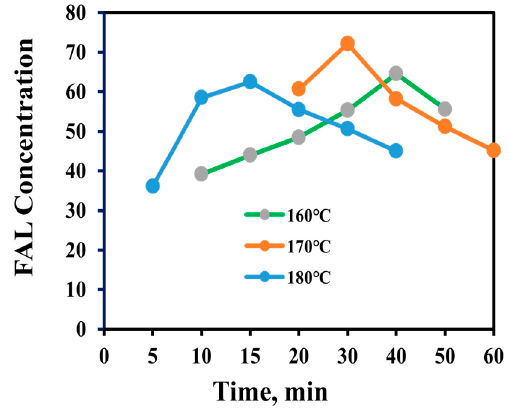
Figure 6. The performance time (5–60 min) and catalytic temperature (160–180 °C) on the influence on the FAL generation. In an autoclave containing 40 mL distilled water, 75 g/L of ground CCB (37.2% glucan, 31.1% xylan, and 16.5% lignin) was blended with UST-Sn-RH (1.5 wt%) and reacted at the designed temperature and reaction duration by stirring at 550 rpm.